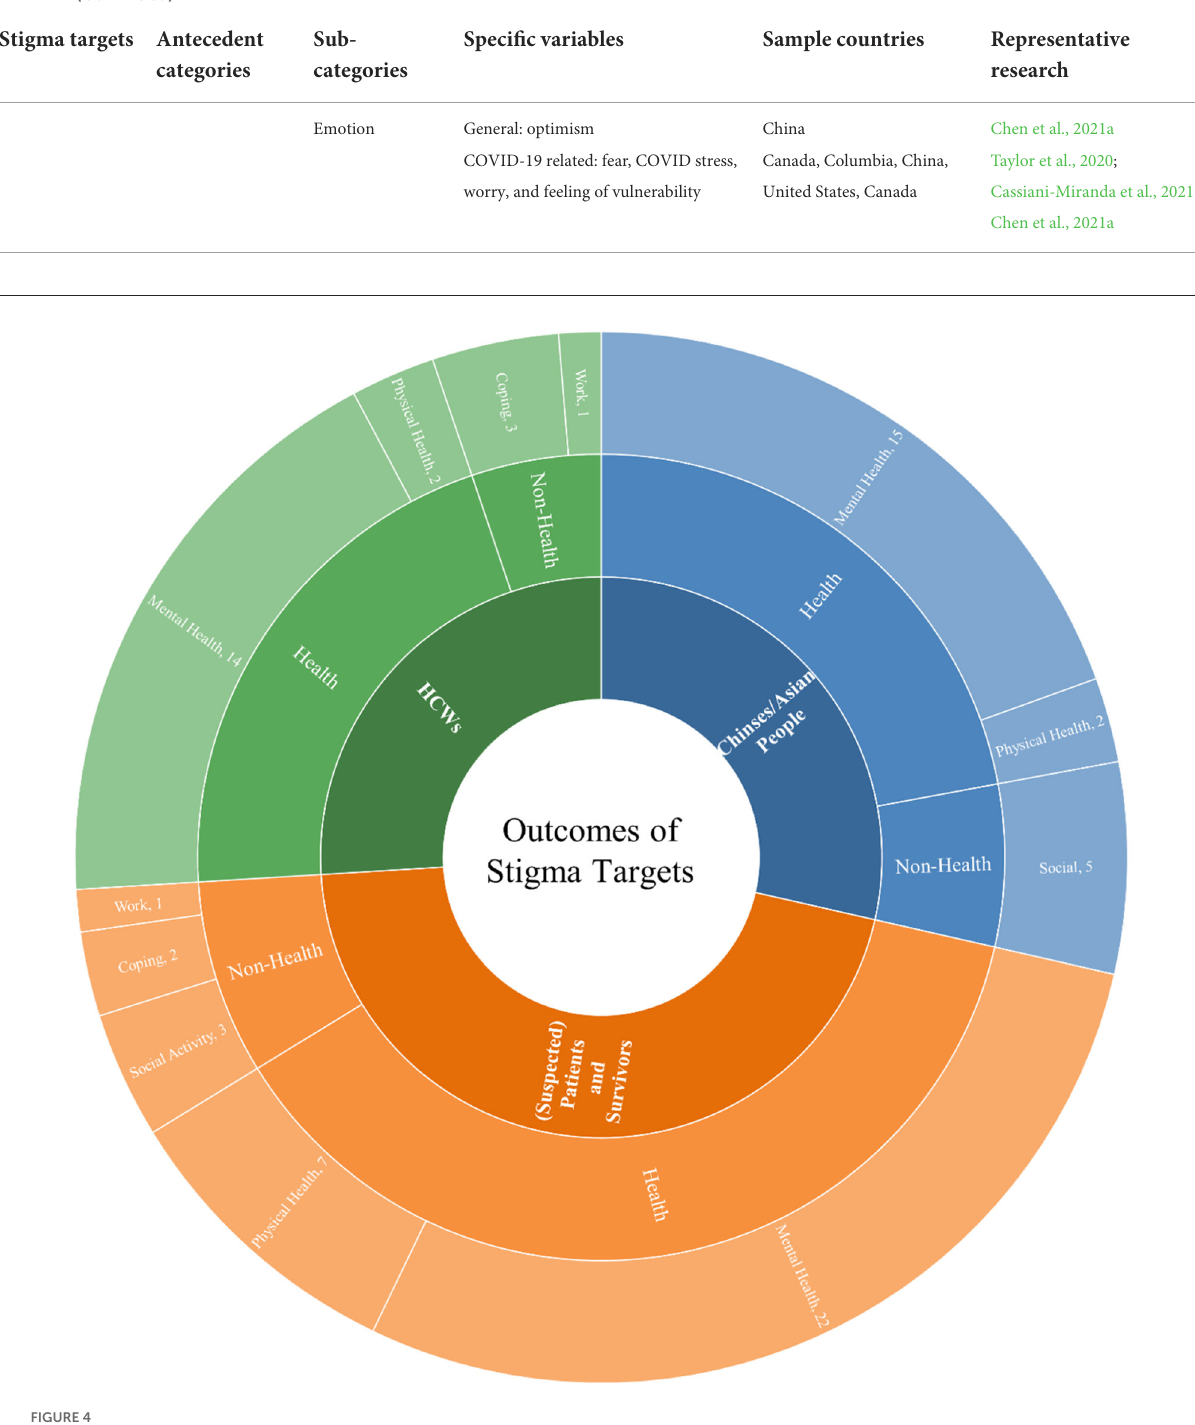
FIGURE4 Summary of the outcomes for stigma targets.